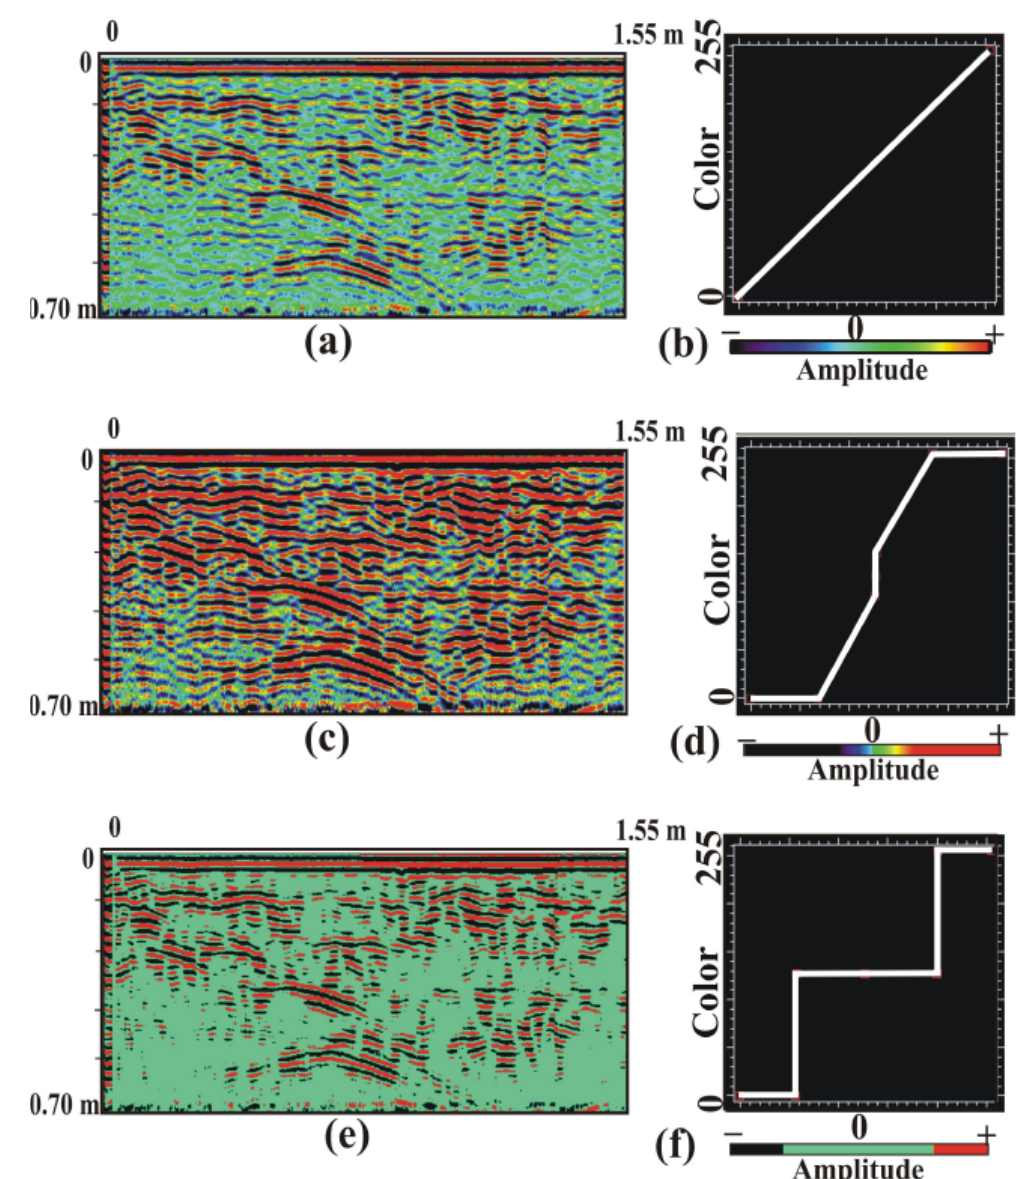
Fig. 7. (a) Radargram of the fourth profile on the skirt part of the first woman statue with (b) linear amplitude-color scale; (c) radargram of the same profile displaying all features of the statues with (d) the new arranged amplitude-color scale which activates all amplitudes (e) radargram of the same profile pointing the fractures and cavities with (f) the new arranged amplitude-color scale which activates only limited maximum negative and positive amplitude